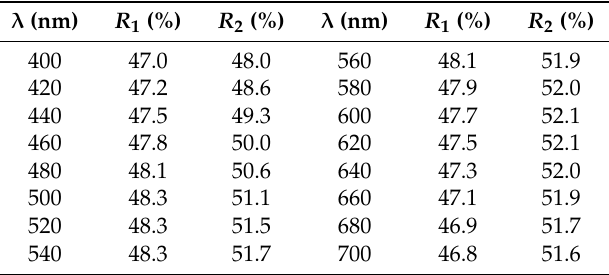
Table 1. Reflectance data.